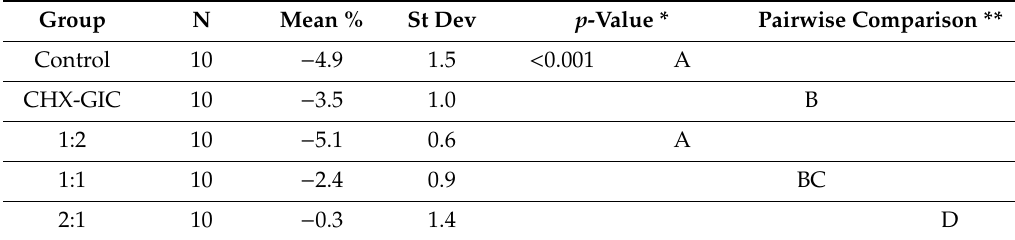
Table 2. Results for the ANOVA and Tukey post hoc test for water solubility values for the control, CHX, and three plant-modified groups (1:2, 1:1, 2:1).